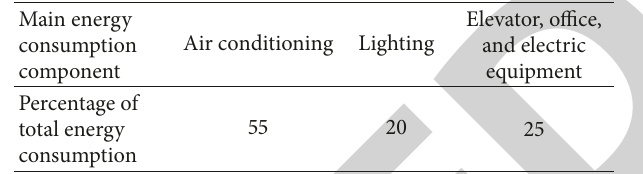
Table 6: Percentages of energy consumption by various processes in the RRSAB.